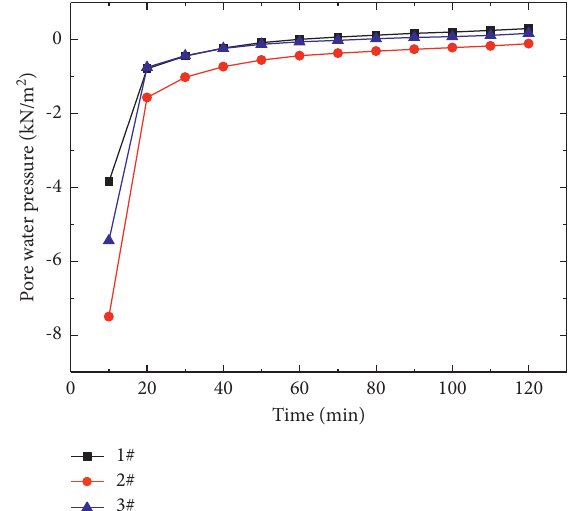
Figure 16: Pore water pressure at observation points 1–3 of building 1 without seepage wells around buildings in the numerical